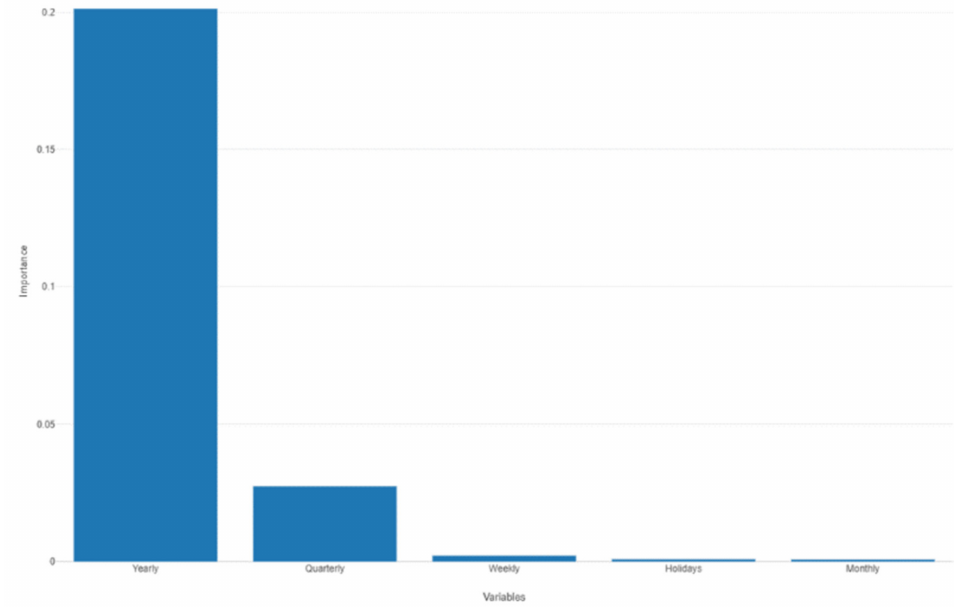
Figure 36. Prophet forecast importance seasonality.